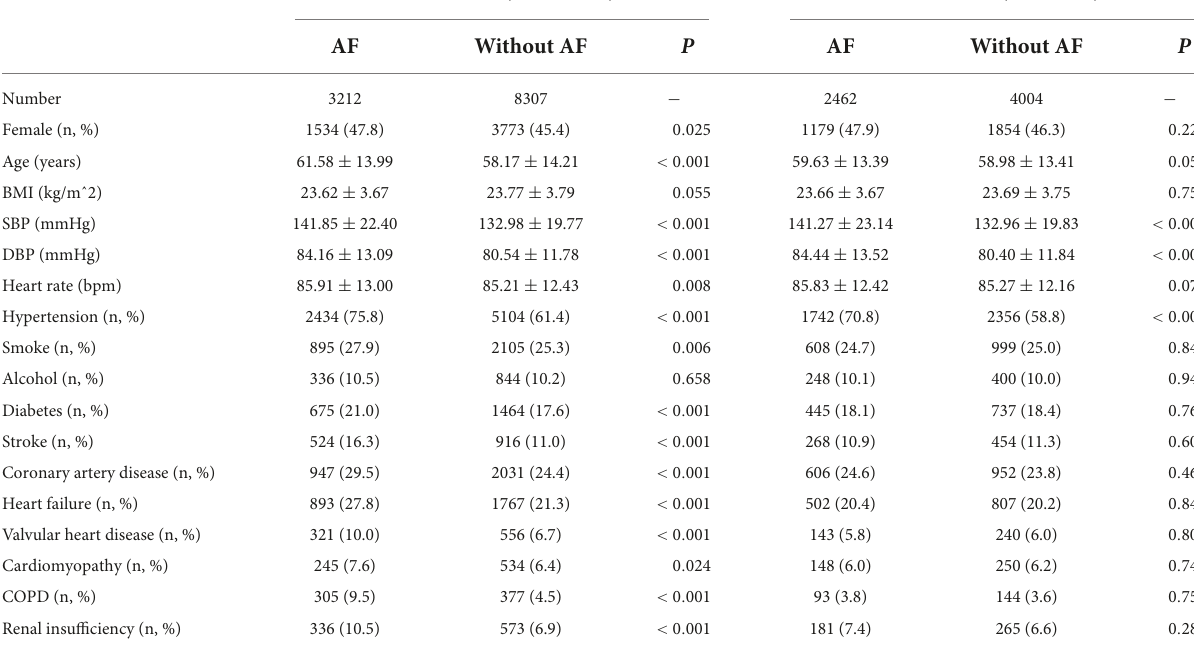
TABLE 1 Characteristics of the